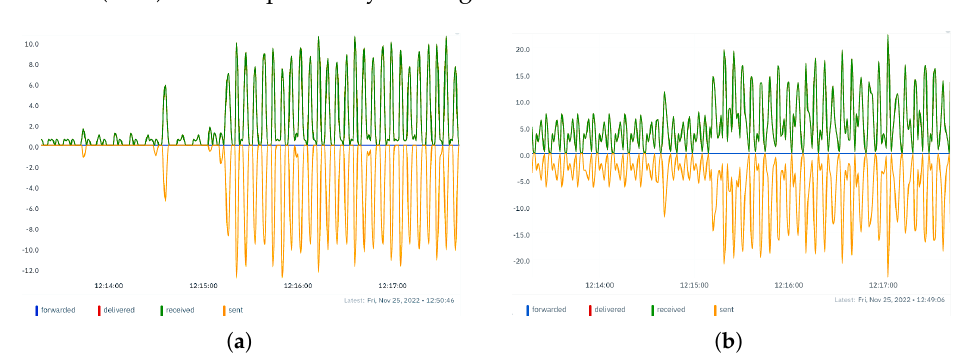
Figure 10. The variation in IPV4 Network Packets by ML model ( a ) Jetson, ( b ) Rasberry Pi (y → packets & x →